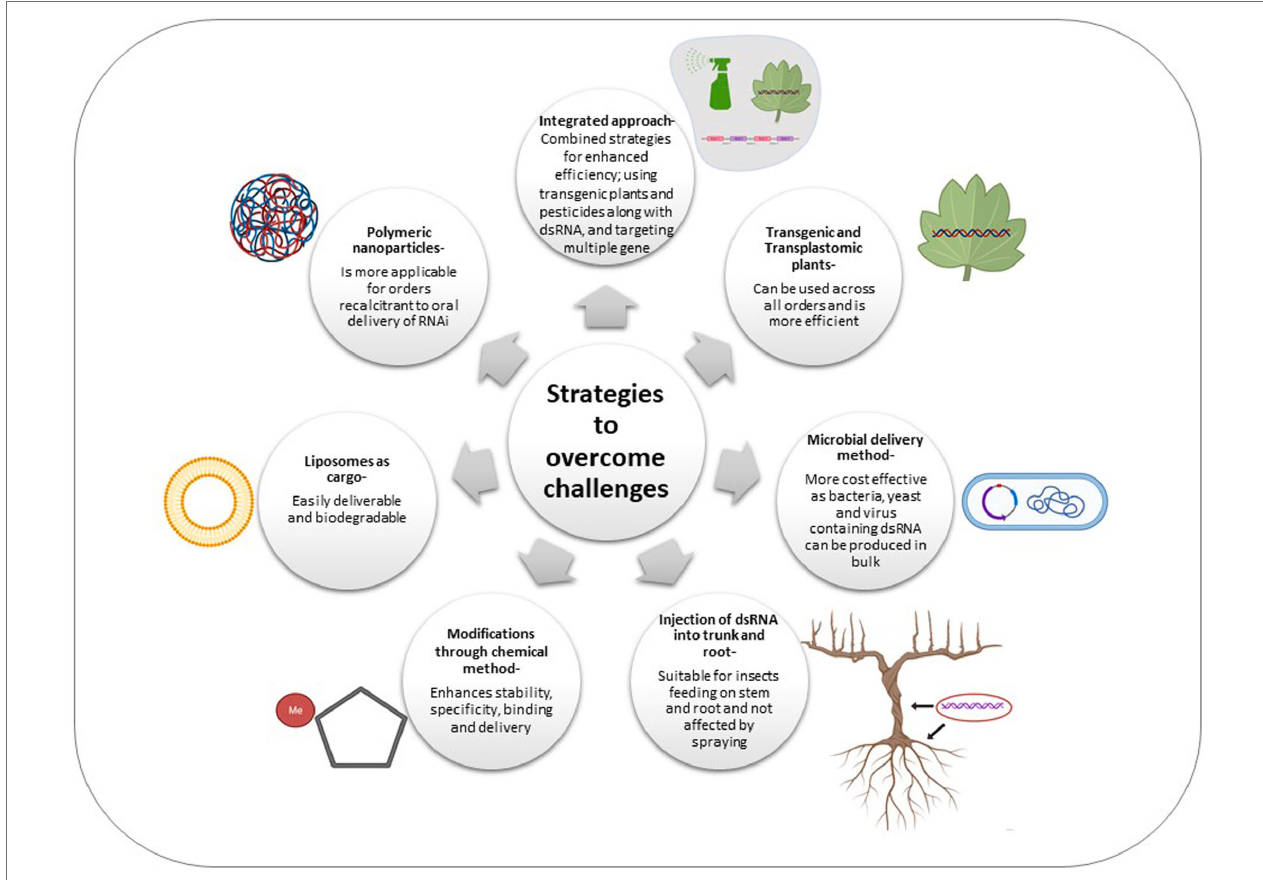
FIGURE 2 | Schematic representation of various strategies adopted to overcome the challenges of RNAi across insect